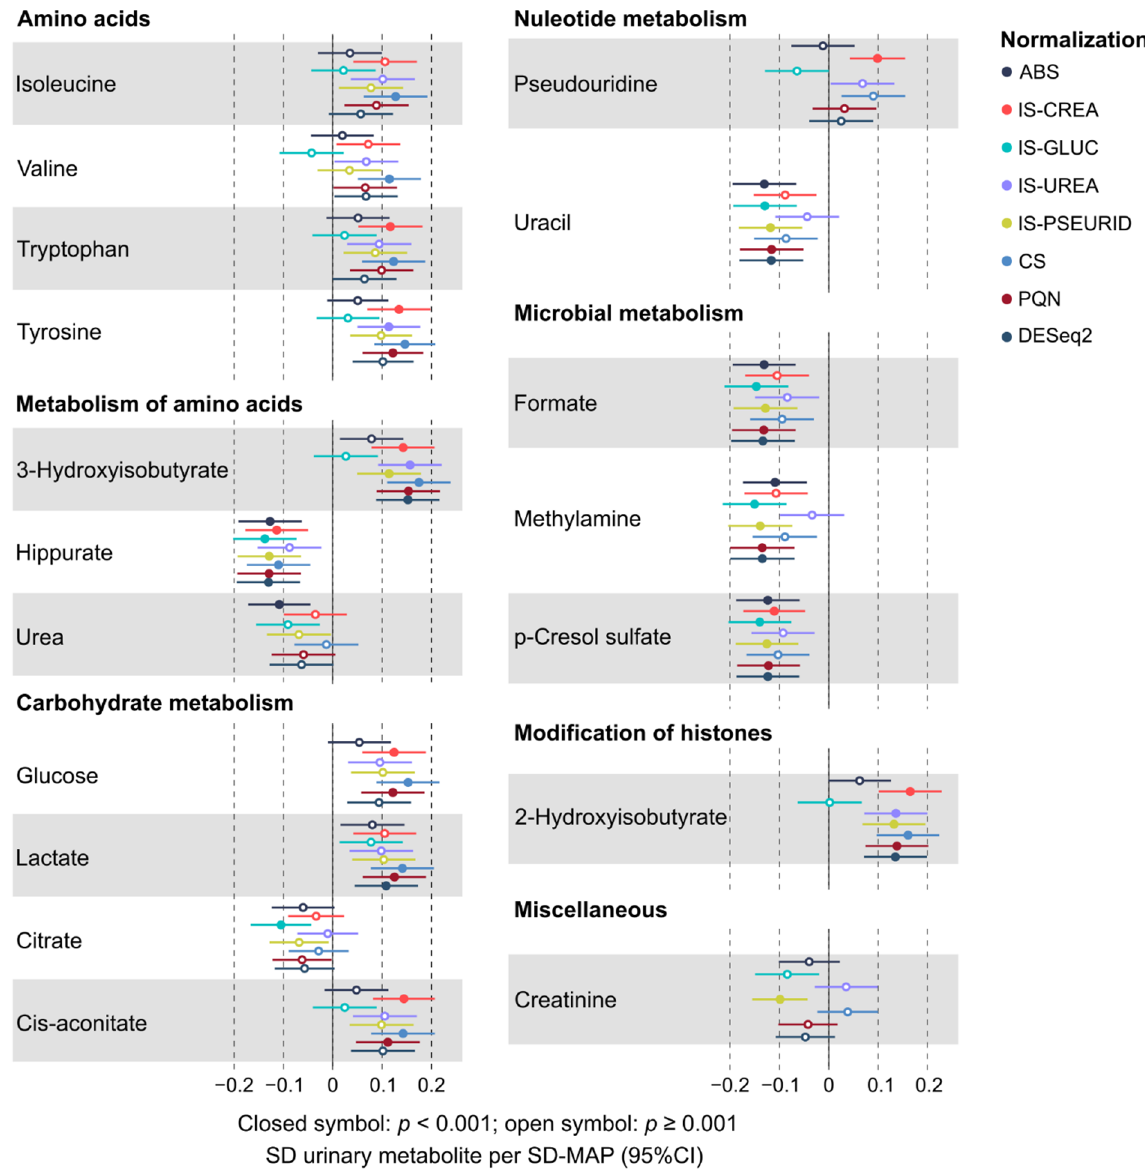
Figure 6. The robust associations ( p < 0.001) of the urinary metabolite concentrations with MAP for the various normalization schemes. See Table 1 for the explanation and basis of the normalization methods.